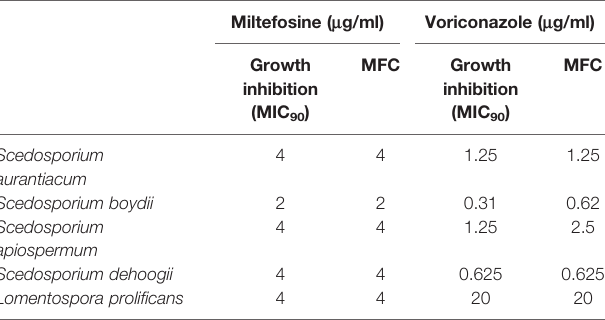
TABLE 1 | MIC 90 , MFC and viability inhibition of miltefosine and voriconazole against Scedosporium and Lomentospora species. Miltefosine ( m